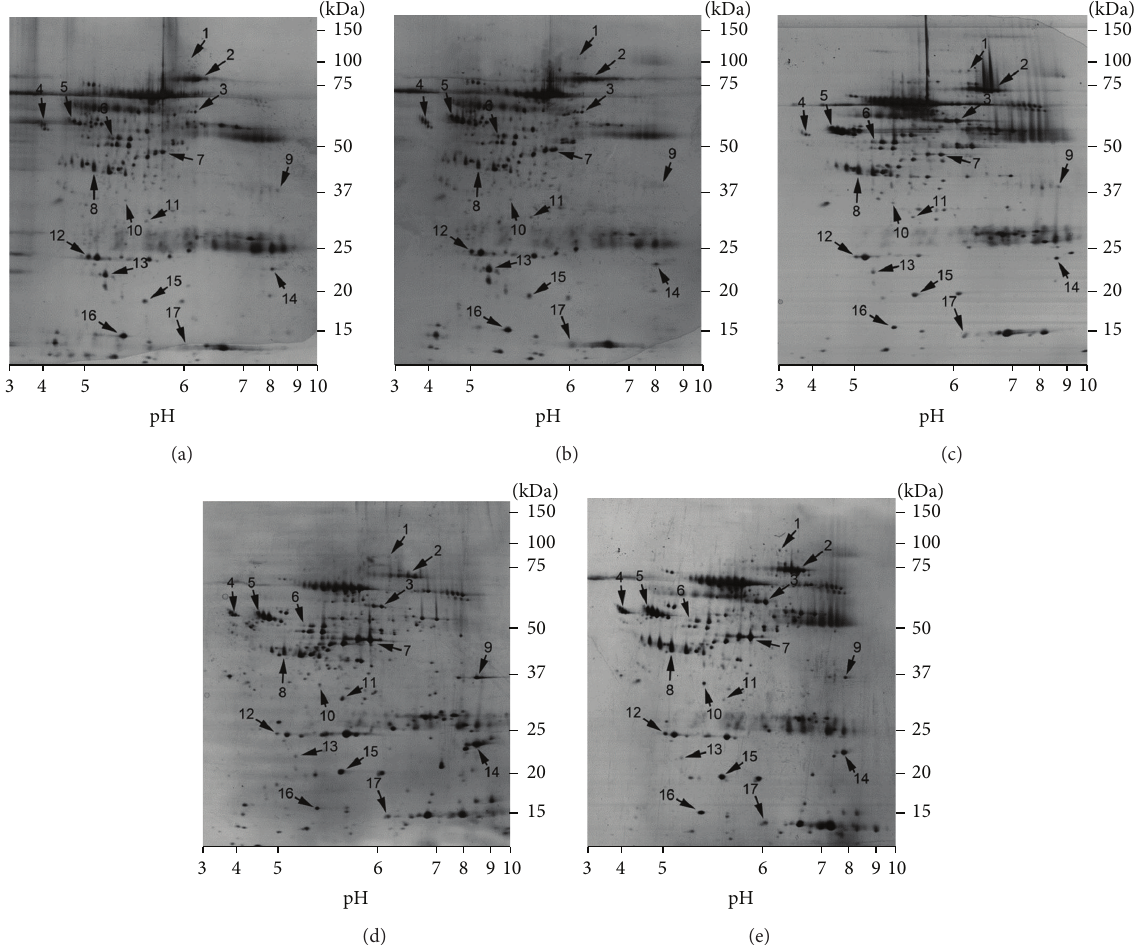
Figure 3: Silver-stained 2-DE gel of proteins from a typical healthy control (a), R306C (b), T158M (c), R168X (d), and large deletions (exons 3 and 4) (e). 60 𝜇 g of total protein was subjected with nonlinear IPG strips, with a pH range of 3 to 10, followed by SDS-polyacrylamide gradient gel(8–16% T)electrophoresis.NumbersdenotetheidentifiedproteinsbymassspectrometryandarelistedinTable 1andSupplementaryTable. Molecular mass (kDa) and pI markers are indicated along the gels.